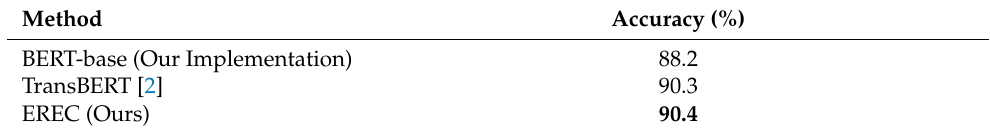
Table 6. Experimental results of story ending prediction on the SCT_v1.5 test dataset.